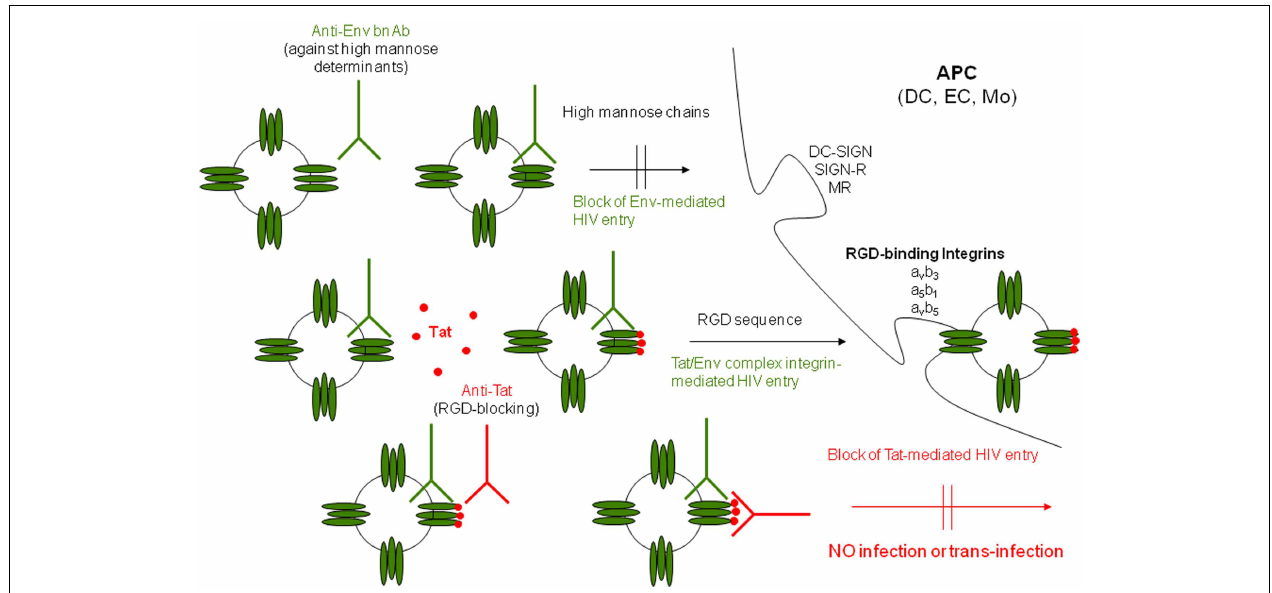
(ECs) present at the site of infection. As a result, virions escape neutralization by anti-Env Abs directed against high mannose determinants and enters target cells upon binding to RGD-binding integrins. Anti-Tat Abs neutralize this binding, preventing virus entry through RGD-binding integrins. DC-SIGN: dendritic cell-specific intercellular adhesion molecule-3-grabbing non-integrin; SIGN-R: homolog of DC-SIGN present on ECs; MR: mannose receptor [modified from Ref.